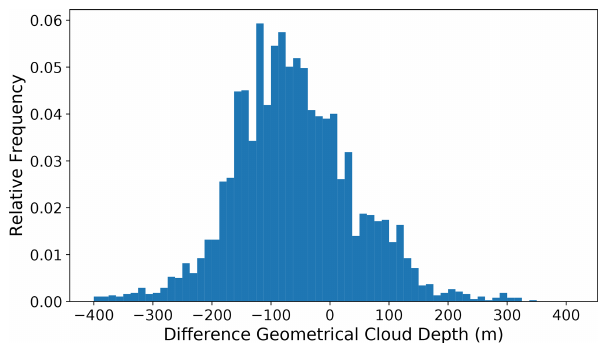
Figure 5. Difference in geometrical cloud depth between ICON and that observed from R/V Polarstern during the period from 2 to 5 June. larger than a threshold of 0.05 gm − 3 . We only assess